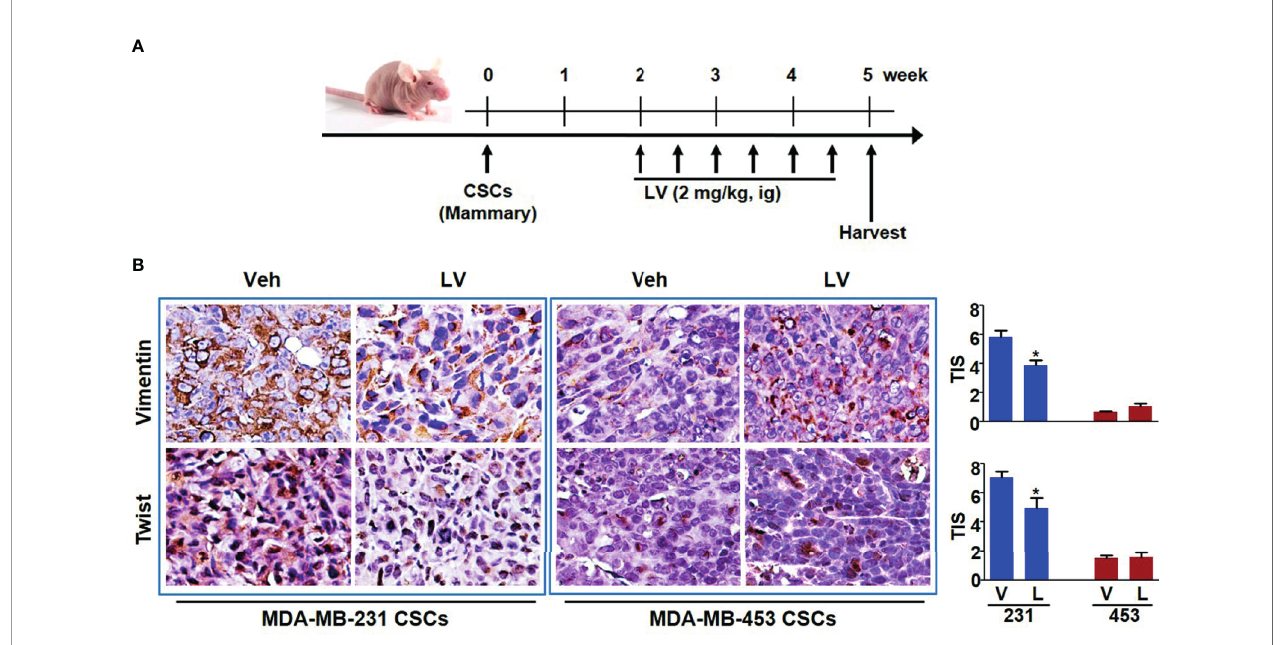
FIGURE 3 | Lovastatin inhibits EMT of TNBC CSCs in vivo . Schematic diagram showing the experimental procedure of mouse model of EMT phenotype (A) . Representative images of immunohistochemical staining for Vimentin and Twist in orthotopic tumors derived from MDA-MB-231 and MDA-MB-453 CSCs. The nucleus was counterstained by hematoxylin. Right, quanti fi cation of the total intensity score (TIS) (B) . * P < 0.05, compared with control; V or Veh, vehicle; L or LV, lovastatin; ig, intragastric administration.